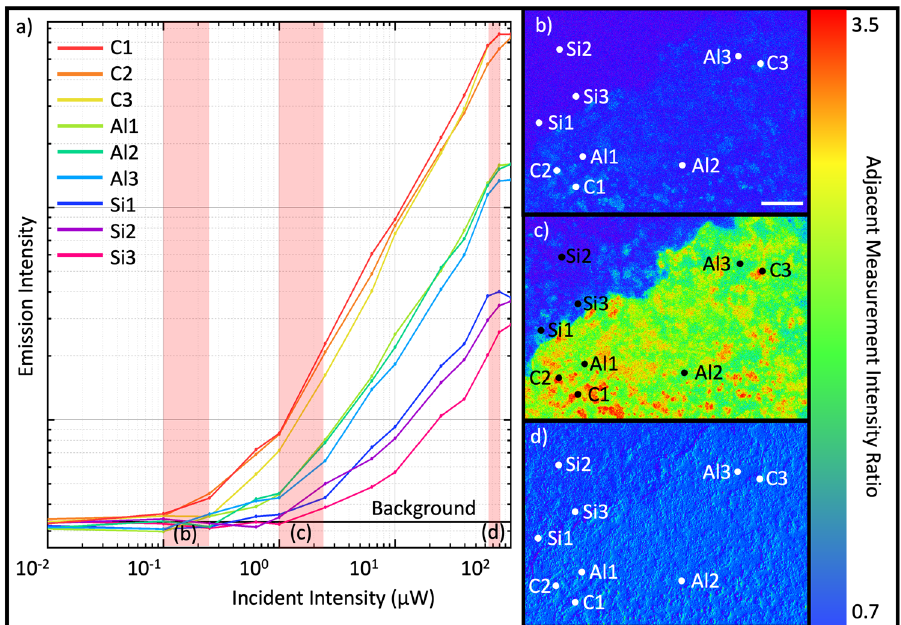
Figure 2. The non-linear optical response of a colloidal quantum dot film. ( a ) Log–log plot showing the emission intensity from a series of points chosen to represent 3 different region types on the sample: QDs on the Si substrate (labels Si1-3), QDs on the Al layer (Al1-3), and QD clusters on the surface (C1-3). ( b )–( d) Show images created by taking the ratio of emission intensity maps recorded at adjacent excitation intensities. These are ( b ) 0.4/0.15 μW, ( c ) 3.6/1.4 μW and ( d ) 115/90 μW. Scale bar represents 50 μm. Z scale represents the relative difference in point-to-point variation on the sample surface.